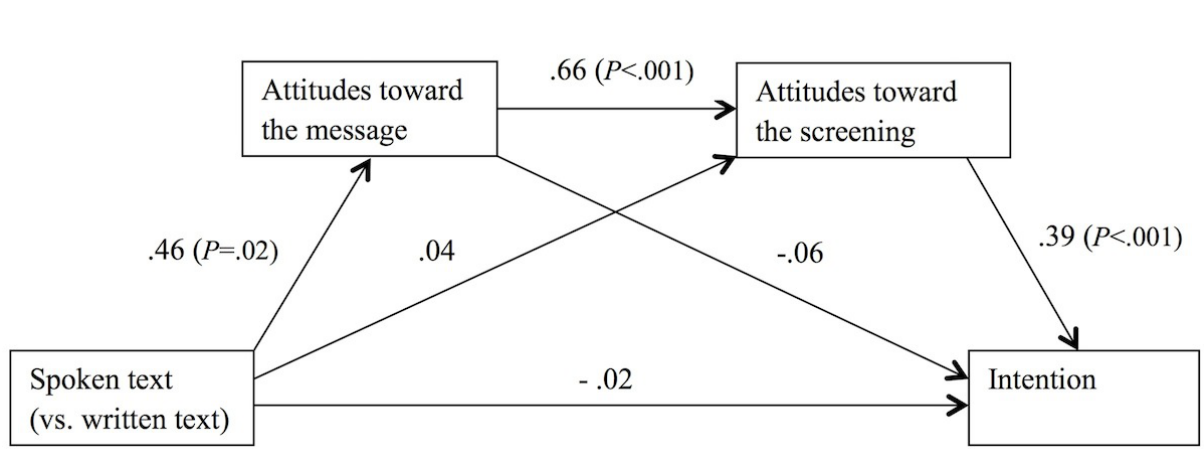
Figure 3. Influence of text modality on intention to screen, mediated by attitudes toward the message and attitudes toward the screening (n=108). Unstandardized regression coefficients are